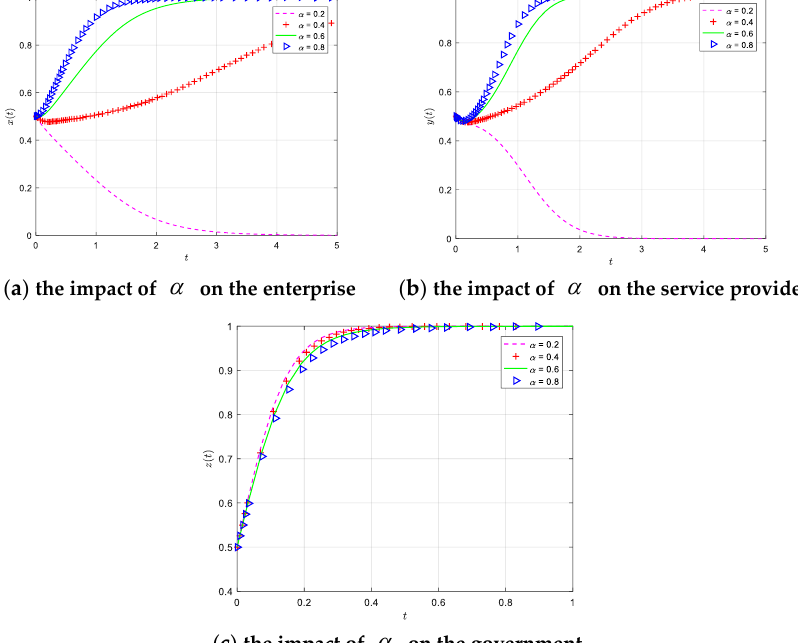
Figure 6. The impact of different tax refund ratios on the enterprise, service provider, and government.